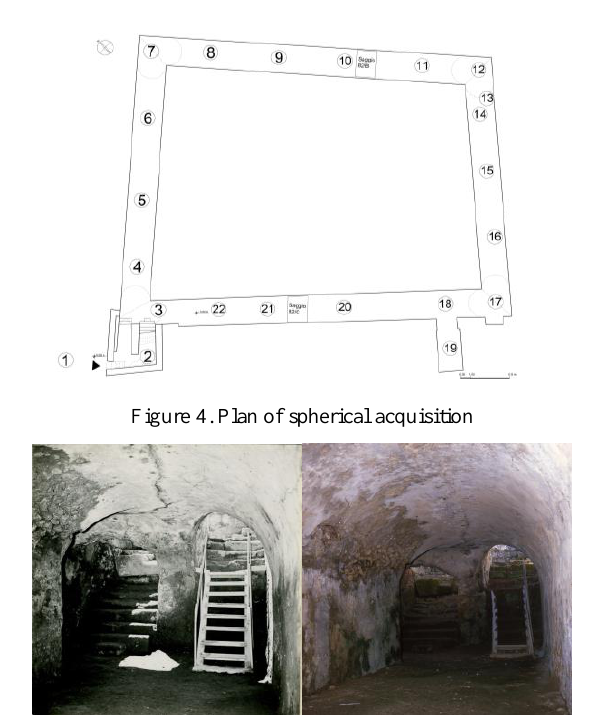
Figure 5. Historical images of an entrance of the Cryptoporticus in different years: On the left, 1965. On the right, 1981-82. Spherical images were obtained using a combined system of camera), a tripod and a led rod in order to solve the low level